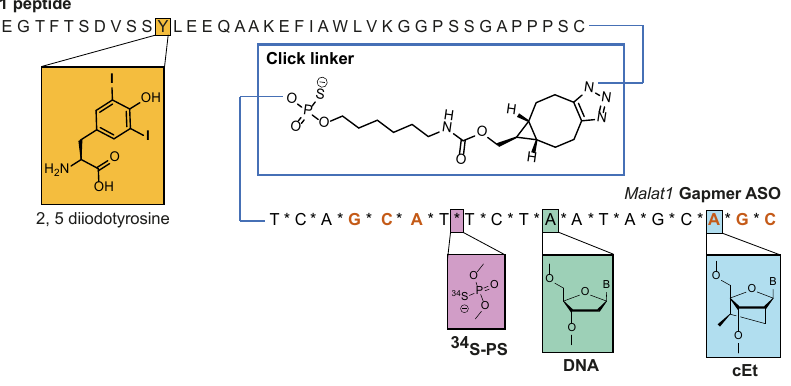
Figure 9. Schematic of double-labelled GLP1-ASO conjugate with click linker.